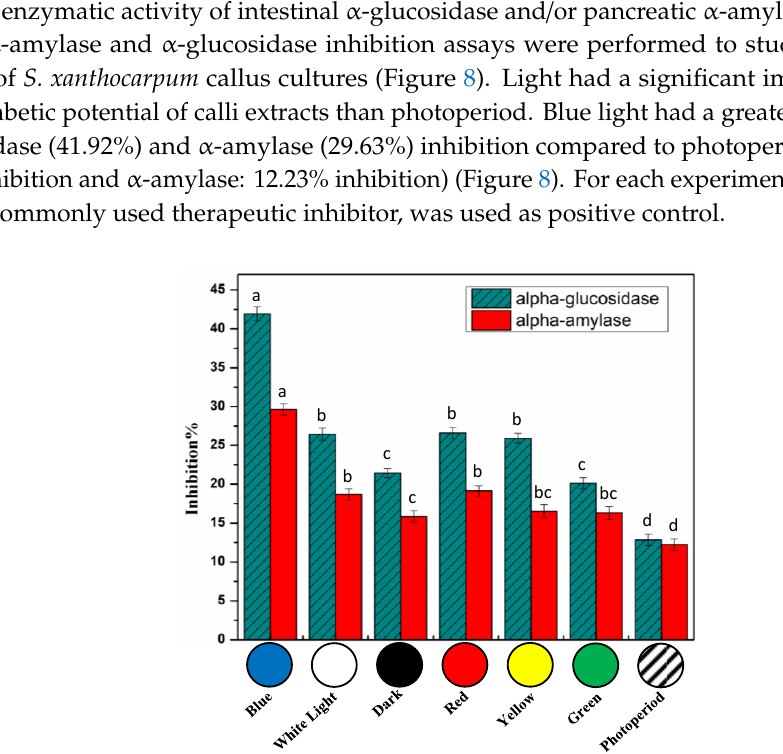
Figure8. In vitrocell-freeantidiabeticactivityactivitiesofextractsfromcallusculturesof S.xanthocarpum Figure 8. In vitro cell-free antidiabetic activity activities of extracts from callus cultures of S. grown under di ff erent monochromatic lights conditions after 35 days of cultivation. Acarbose (10 µ M) xanthocarpum grown under different monochromatic lights conditions after 35 days of cultivation . was used as positive control, leading to enzyme inhibition of 65.6 ± 4.1% and 89.2 ± 0.5% for α -glucosidase and α -amylase, respectively. The same volume of extraction solvent was used as blank. Data are expressed in terms of mean ± SD of at least three independent experiments. Di ff erent letters indicate significant di ff erences between conditions ( p <